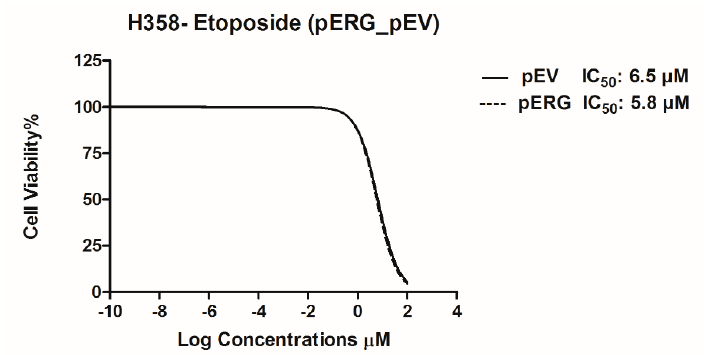
Figure 2. IC 50 graphs of pERG and pEV transfected H358 cell line after treatment with